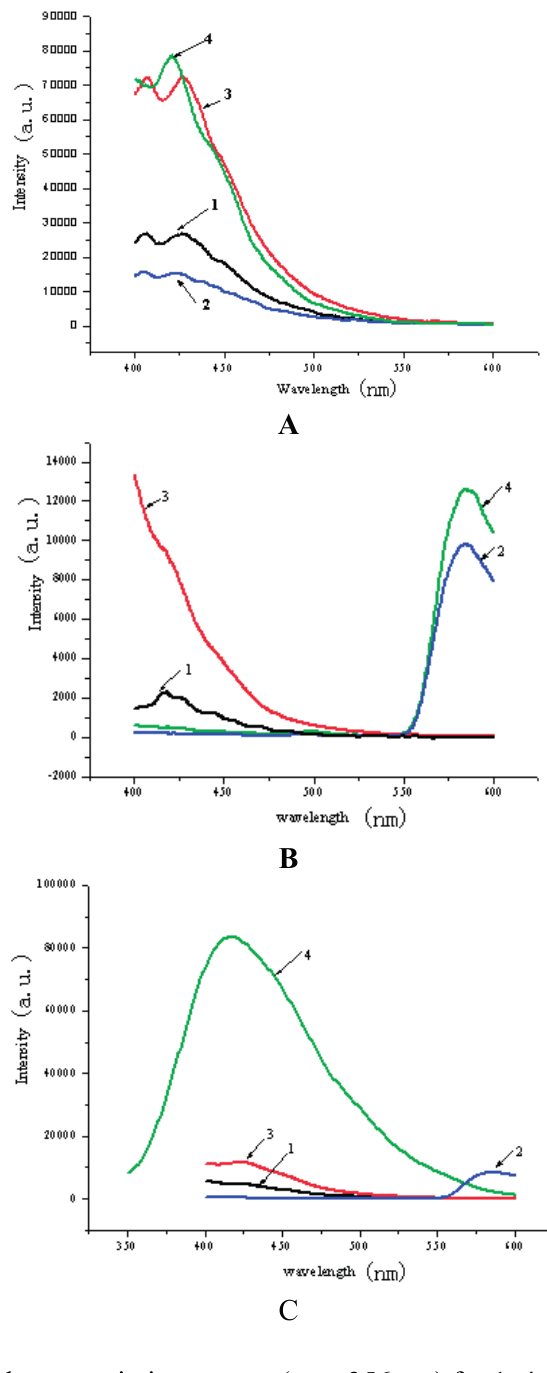
Figure 5. ( A ) The solid-state emission spectra (ex = 356 nm) for 1 – 4 ; ( B ) The emission spectra (ex = 356 nm) for 1 – 4 in methanol solution and ( C ) The emission spectra (ex = 356 nm) for 1 – 4 in